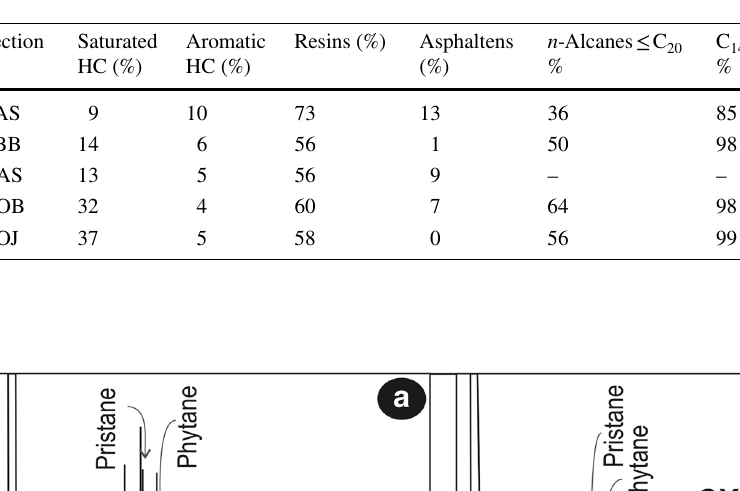
Fig. 5 Chromatograms show- ing: a a non biodegraded hydrocarbons from dark shale; b biodegraded hydrocarbons of saturated dichloromethane extracted fraction showing a hump from organic poor light grey limestone of Bir M’Cherga source rocks (Corel Draw figure exported into jpeg